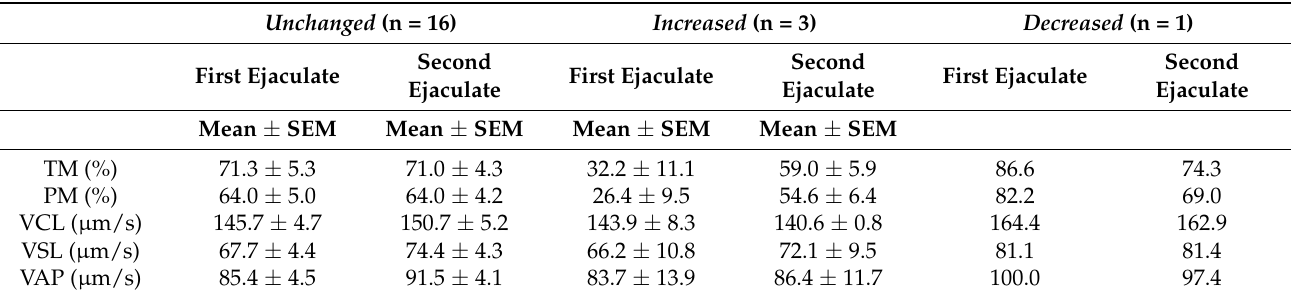
Table 7. Qualitative comparison of the first and second ejaculates collected from breeding inactive stallions (n = 20). Based on the motility parameters between the first and second ejaculates, sixteen stal- lions were classified as unchanged (i.e., ≤ 10% change), three stallions as increased (i.e., improvement >10%), and one stallion as decreased (i.e., reduction >10%).